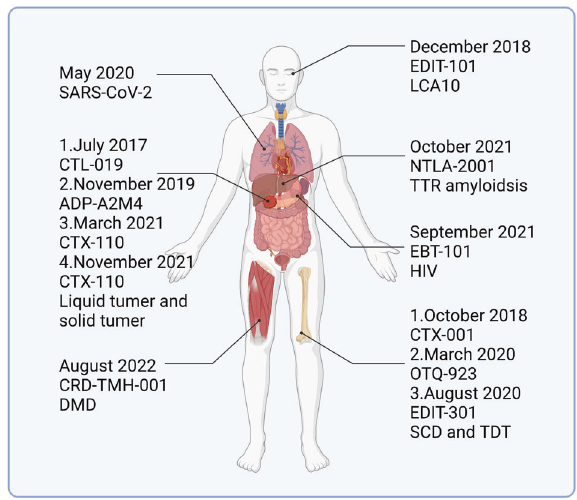
Fig. 7 Summary chart of FDA-approved CRISPR therapies that can be used in clinical treatments. The text includes the date of FDA approval, the name of the therapy, and the type of applied diseases. DMD Duchenne muscular dystrophy, SCD sickle cell disease, TDT transfusion-dependent β -thalassemia, LCA10 Leber congenital amauro- sis type 10, TTR transthyretin. (Figure was created with